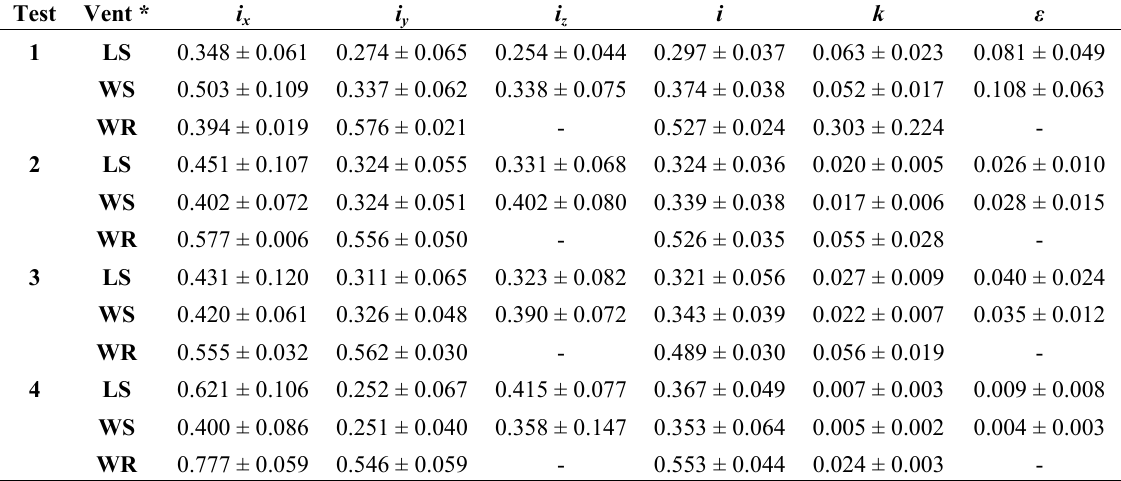
Table 4. Mean value of the parameters that characterise the turbulent airflow close to the vents: i , turbulence intensity (longitudinal component, x ; transversal component, y ; vertical component, z ); k , turbulence kinetic energy [m 2 s − 2 ]; ε , energy dissipation rate [m 2 s − 3